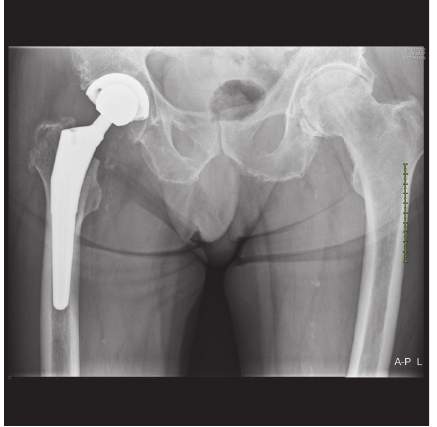
Figure 3: Uncemented total hip arthroplasty without signs of loosening at 15-month follow-up.